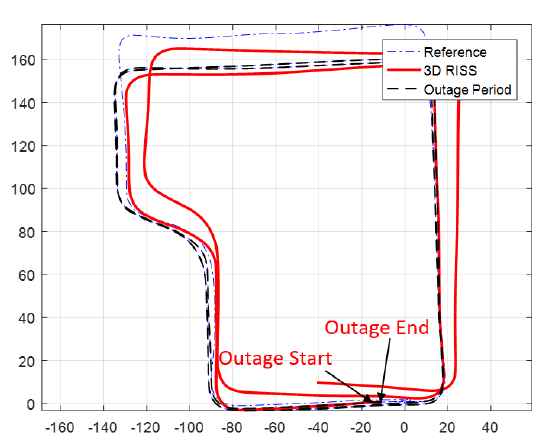
Figure 19. Modified 3D RISS trajectory for 180 seconds GNSS signal outage